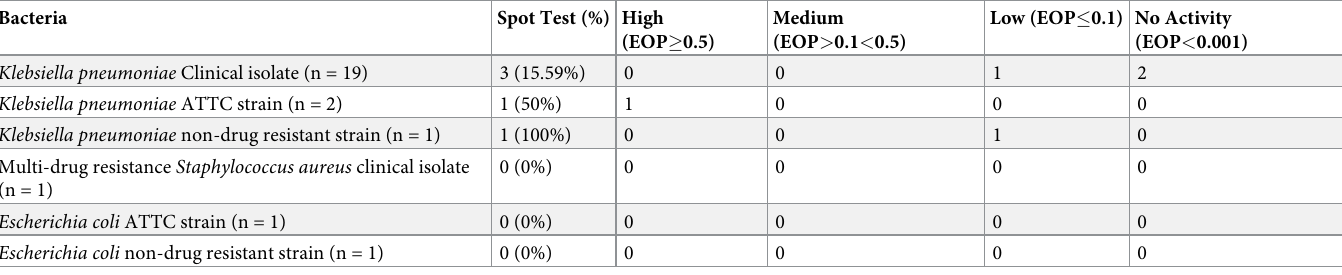
EOP was calculated using double-layer method. EOP is classified as ‘High’ only when the ratio of compared bacterium to their host is at minimum or higher than 50% (EOP � 0.5), ‘Medium’ when the EOP is in between 10% and 50% (0.1 � EOP < 0.5), ‘Low’ when less than 10%, and ‘Inefficient’ when EOP is less than 0.1% (EOP �